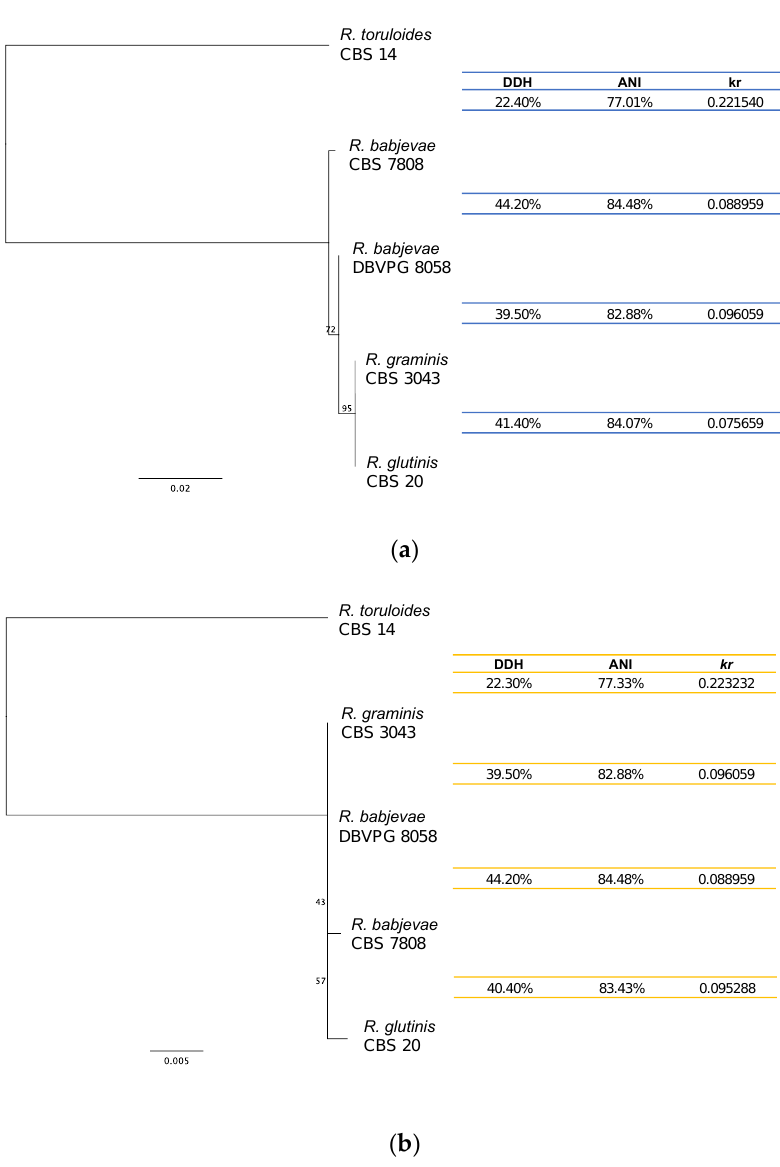
Figure 5. Phylogenetic relationship of Rhodotorula babjevae strains and their placement within the Rhodotorula genus. The phylogenetic tree was built based on: ( a ) ITS; and ( b ) D1/D2 LSU of rRNA gene sequences. It was inferred using PhyML with 100 bootstraps on Geneious prime version 2021.0.1. Rhodotorula toruloides was selected as outgroup. Similarities between whole genome sequences of the corresponding strains are presented in terms of the alignment-free distance measure kr , Average Nucleotide Identity (ANI), and DNA – DNA homology (DDH). Rhodotorula graminis WP1 and R. glutinis ZHK genome sequences were used for the calculations instead of R. graminis CBS 3043 and R. glutinis CBS 20, respectively.